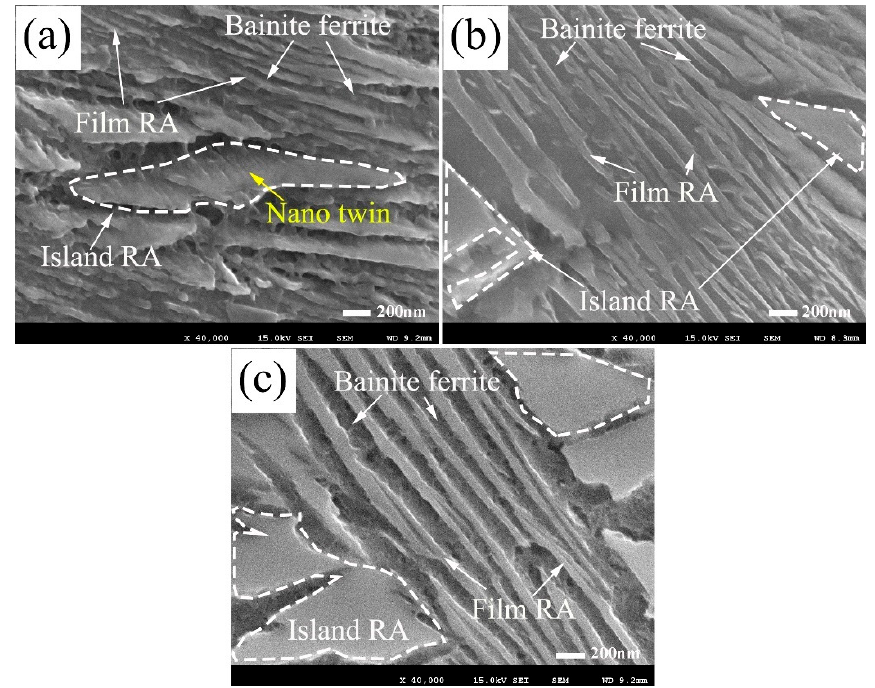
Figure 6. Magnified scanning electron micrographs of the inner dendrite regions in the coatings ( a ) obtained at 200 °C for 24 h, ( b ) obtained at 250 °C for 16 h, ( c ) obtained at 300 °C for 8 h.